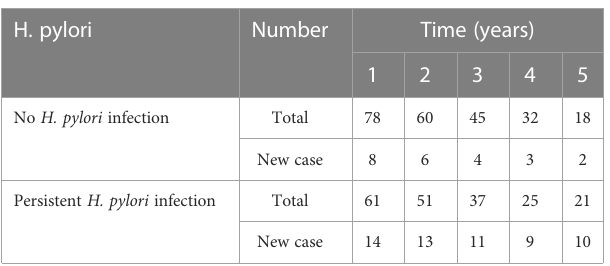
TABLE 3 New cases of patients with TNs at annual follow-up for 5 years.